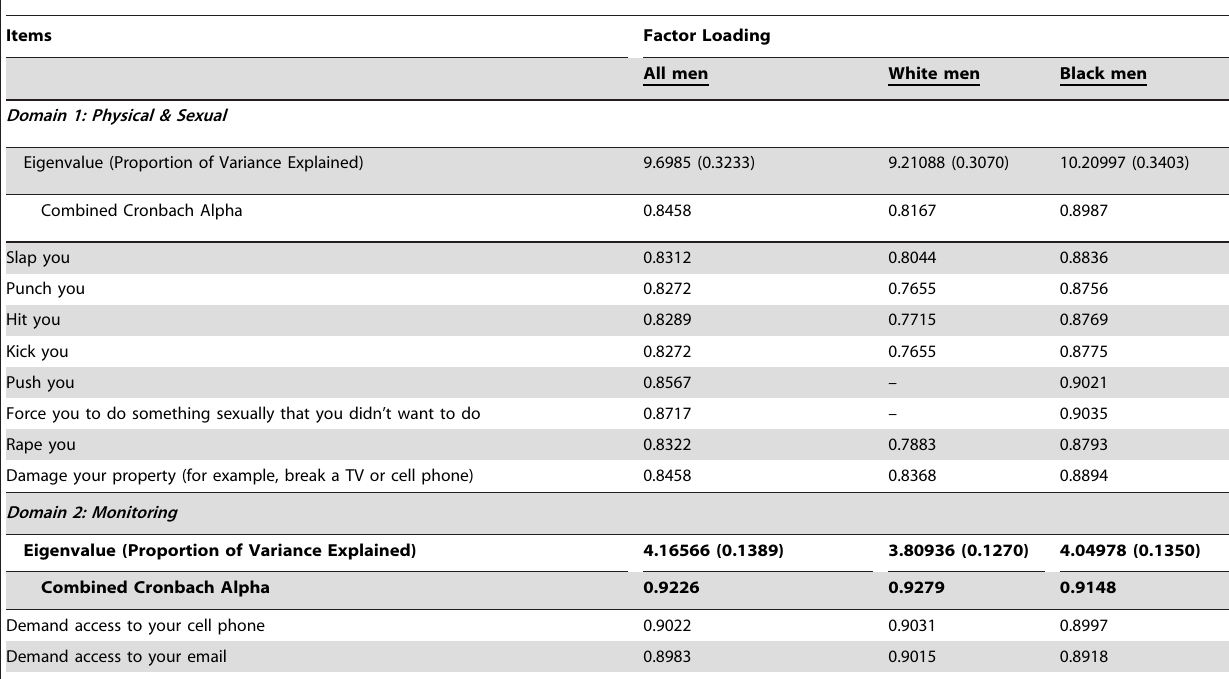
Items Factor Loading